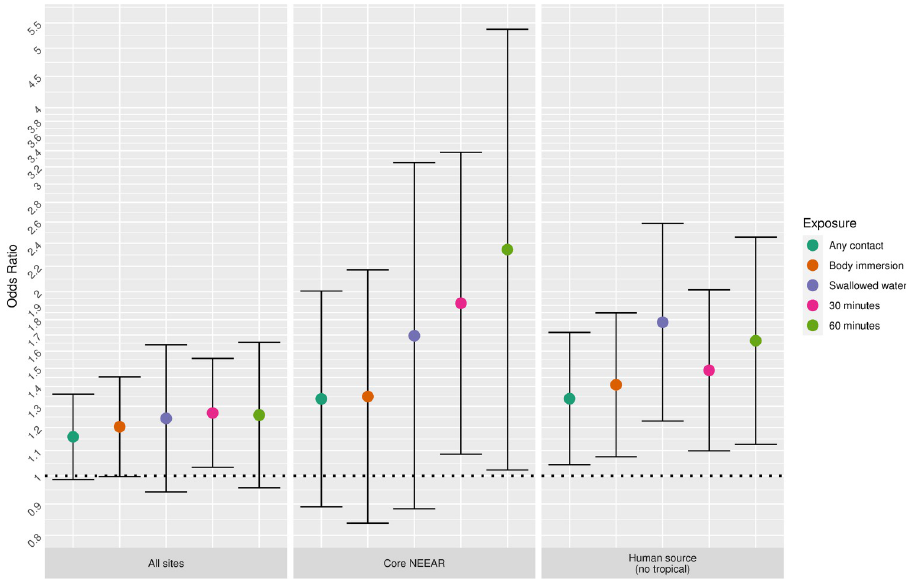
Fig 7. Odds ratios for respiratory illness among swimmers associated with a 1- log 10 increase in Enterococcus qPCR CE among children 4 years and